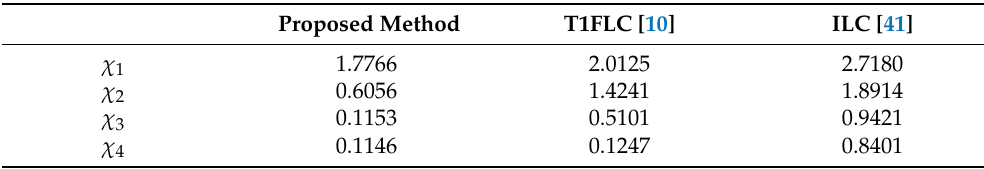
Table 2. Performance